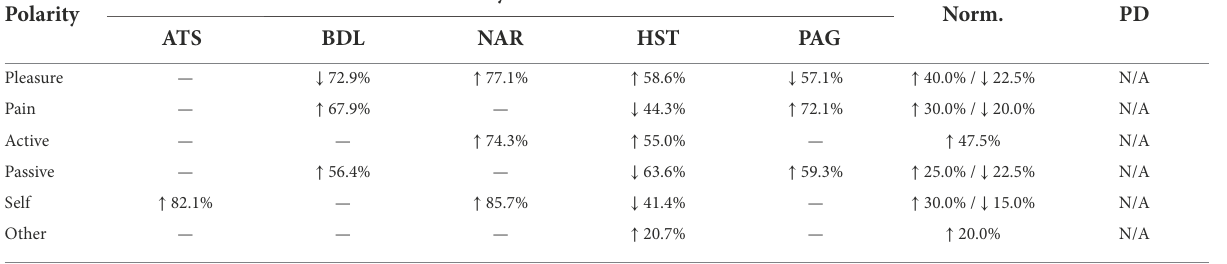
TABLE 5 Probabilities (%) of polarities for cluster-B personality disorders. Personality disorders Polarity